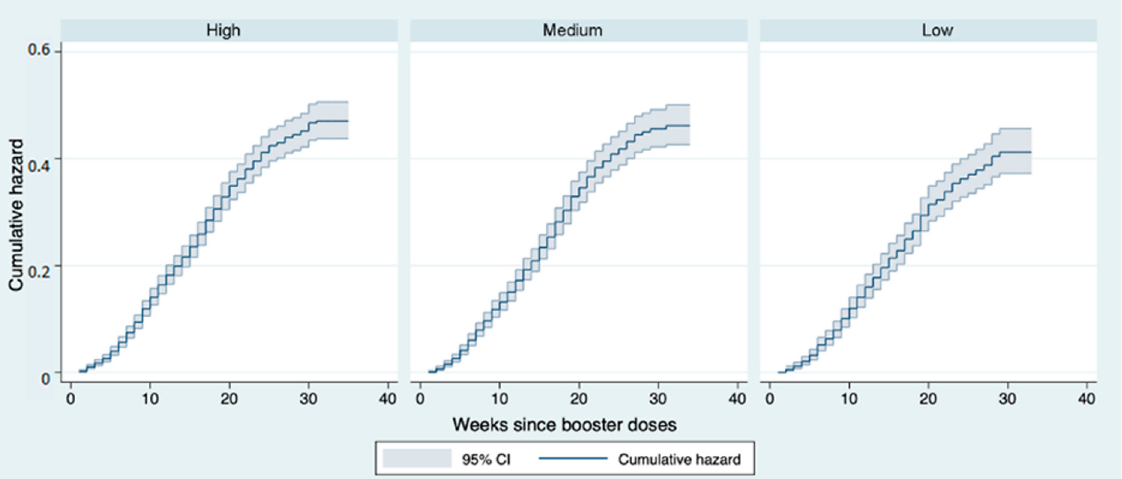
Figure 6. Nelson–Aalen cumulative hazard estimates: curves representing the cumulative risk of infection after booster dose stratified by operating unit in the follow-up period.